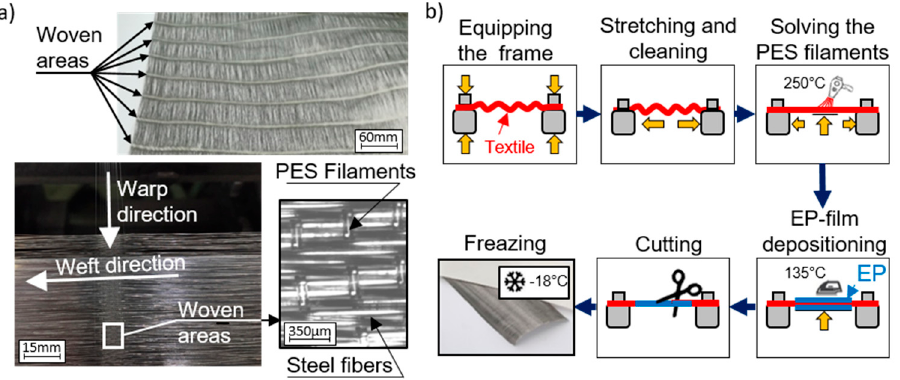
Figure 2. ( a ) Woven structure of the quasi-unidirectional steel fiber fabric; and ( b ) manufacturing process of the pre-impregnated steel fiber textiles. process of the pre-impregnated steel fiber